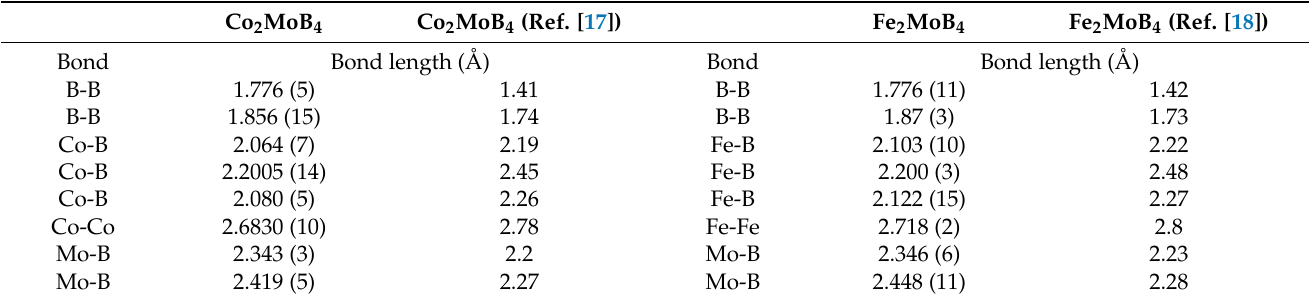
Table 2. A brief summary of bond lengths of synthesized compounds determined by X-ray single crystal